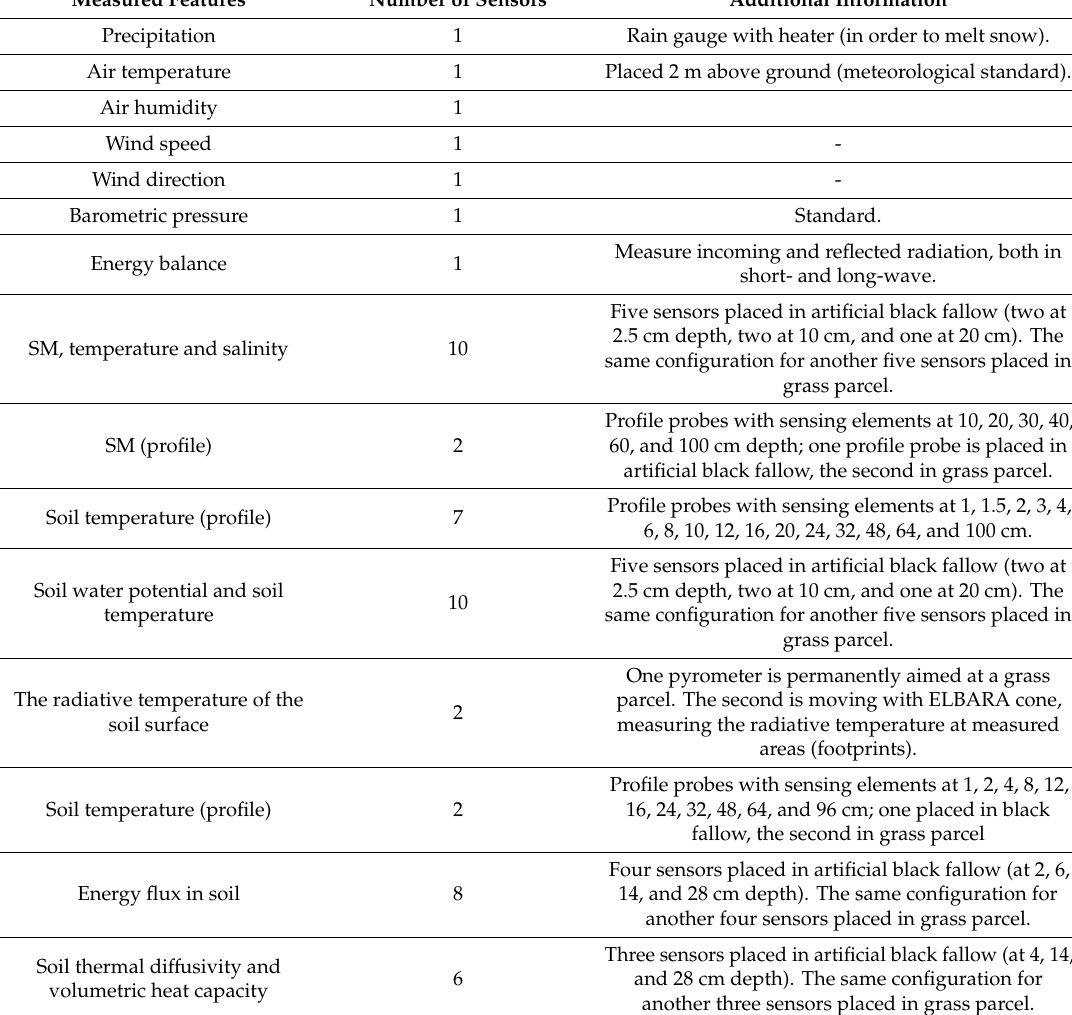
Table 1. The measurement capabilities of the stations on the Bubn ó w test